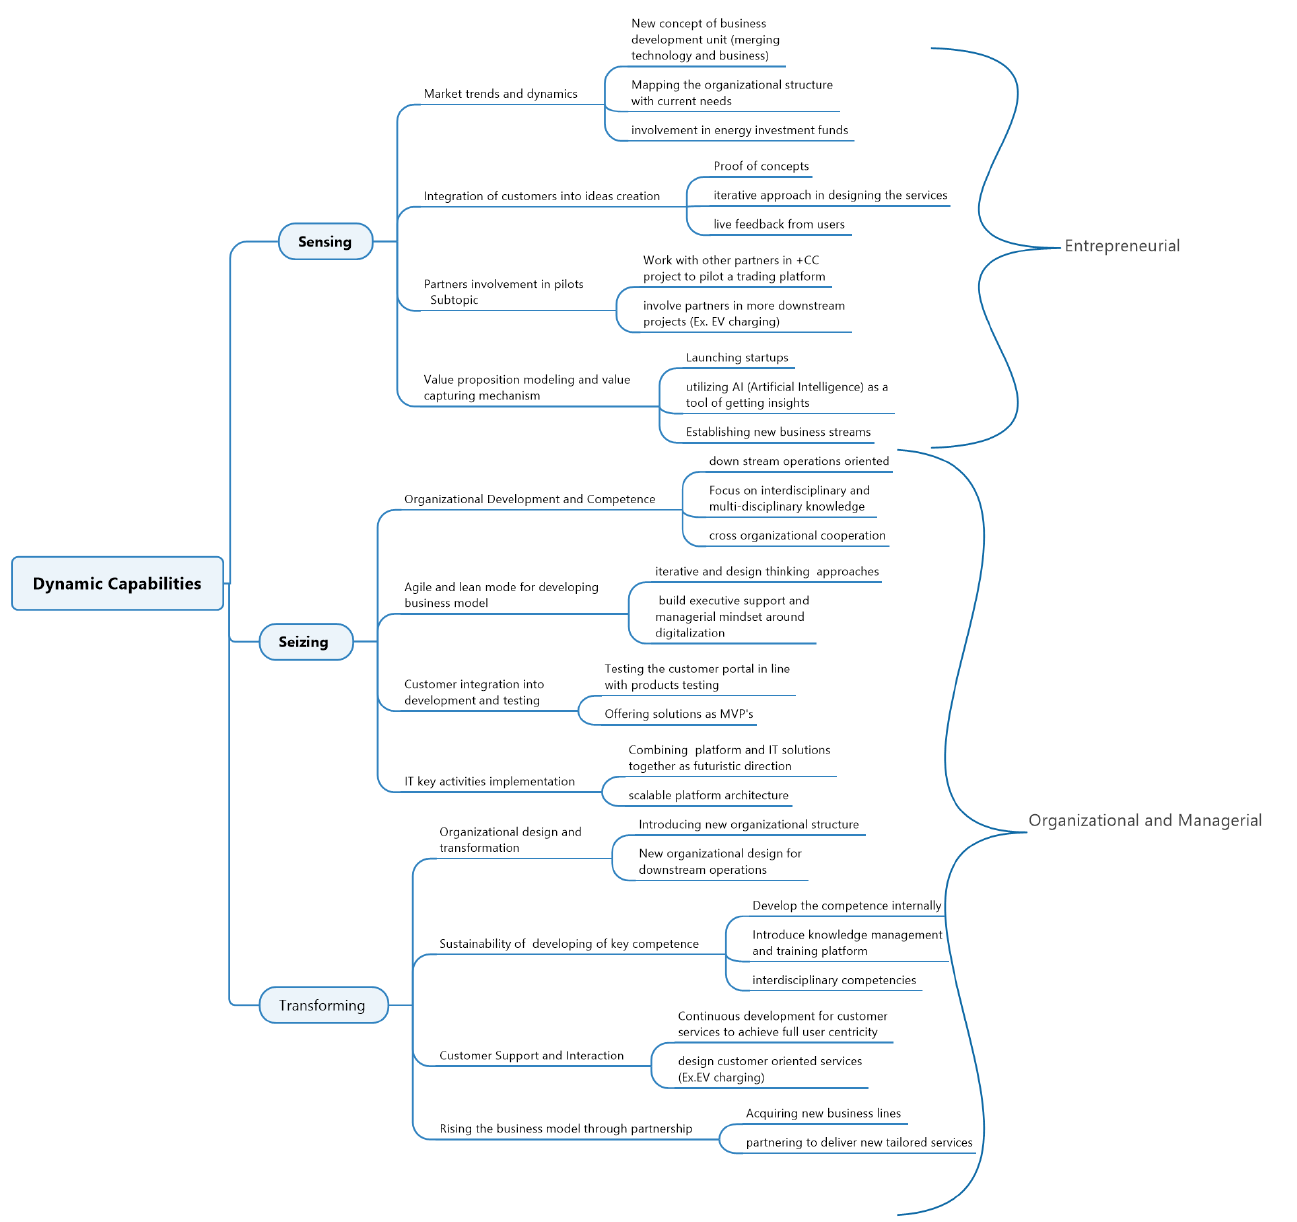
Figure 4. Dynamic capabilities activities